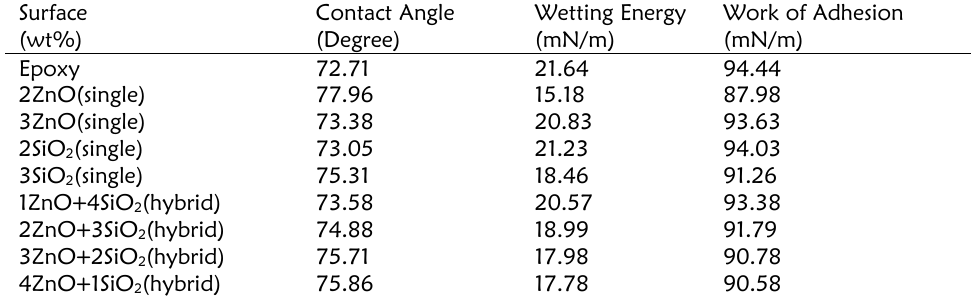
Table 2: Contact Angle of Nanocoating (Water Drop)